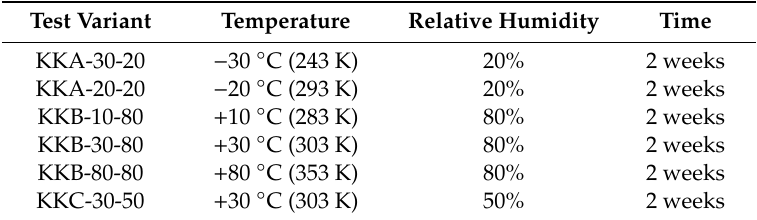
Table 3. Sample exposure data—climatic chamber.